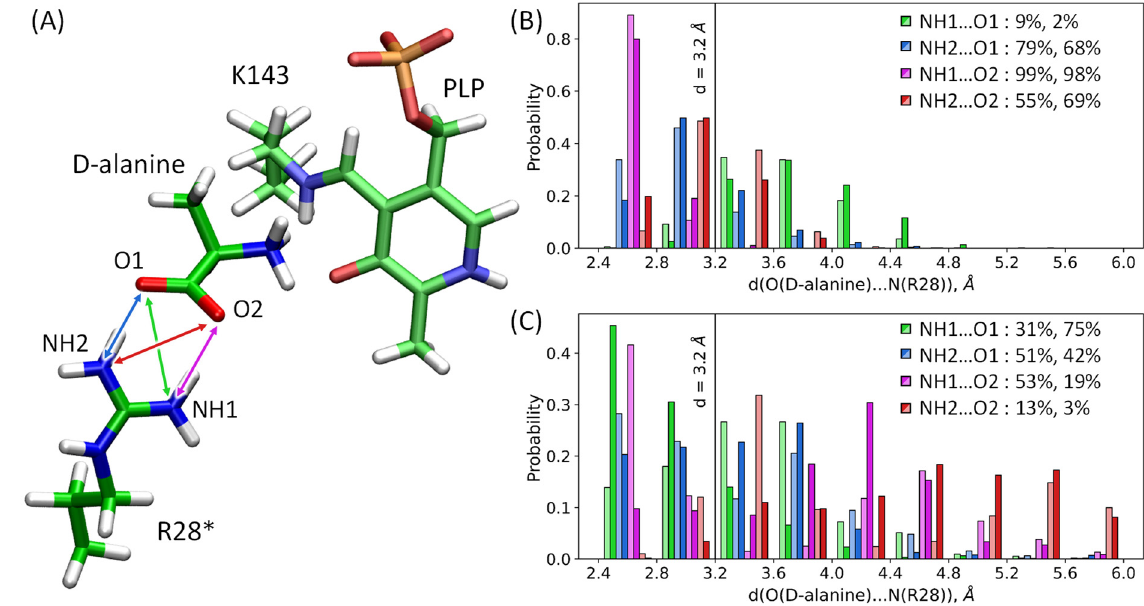
between the non-hydrogen atoms less than 3.2 Å). The values for the subunits are given separately. Here and in Figure 6, the color code for molecular models is the following: carbon—green, oxygen—red, nitrogen—blue, hydrogen—white, and phosphorus—orange.